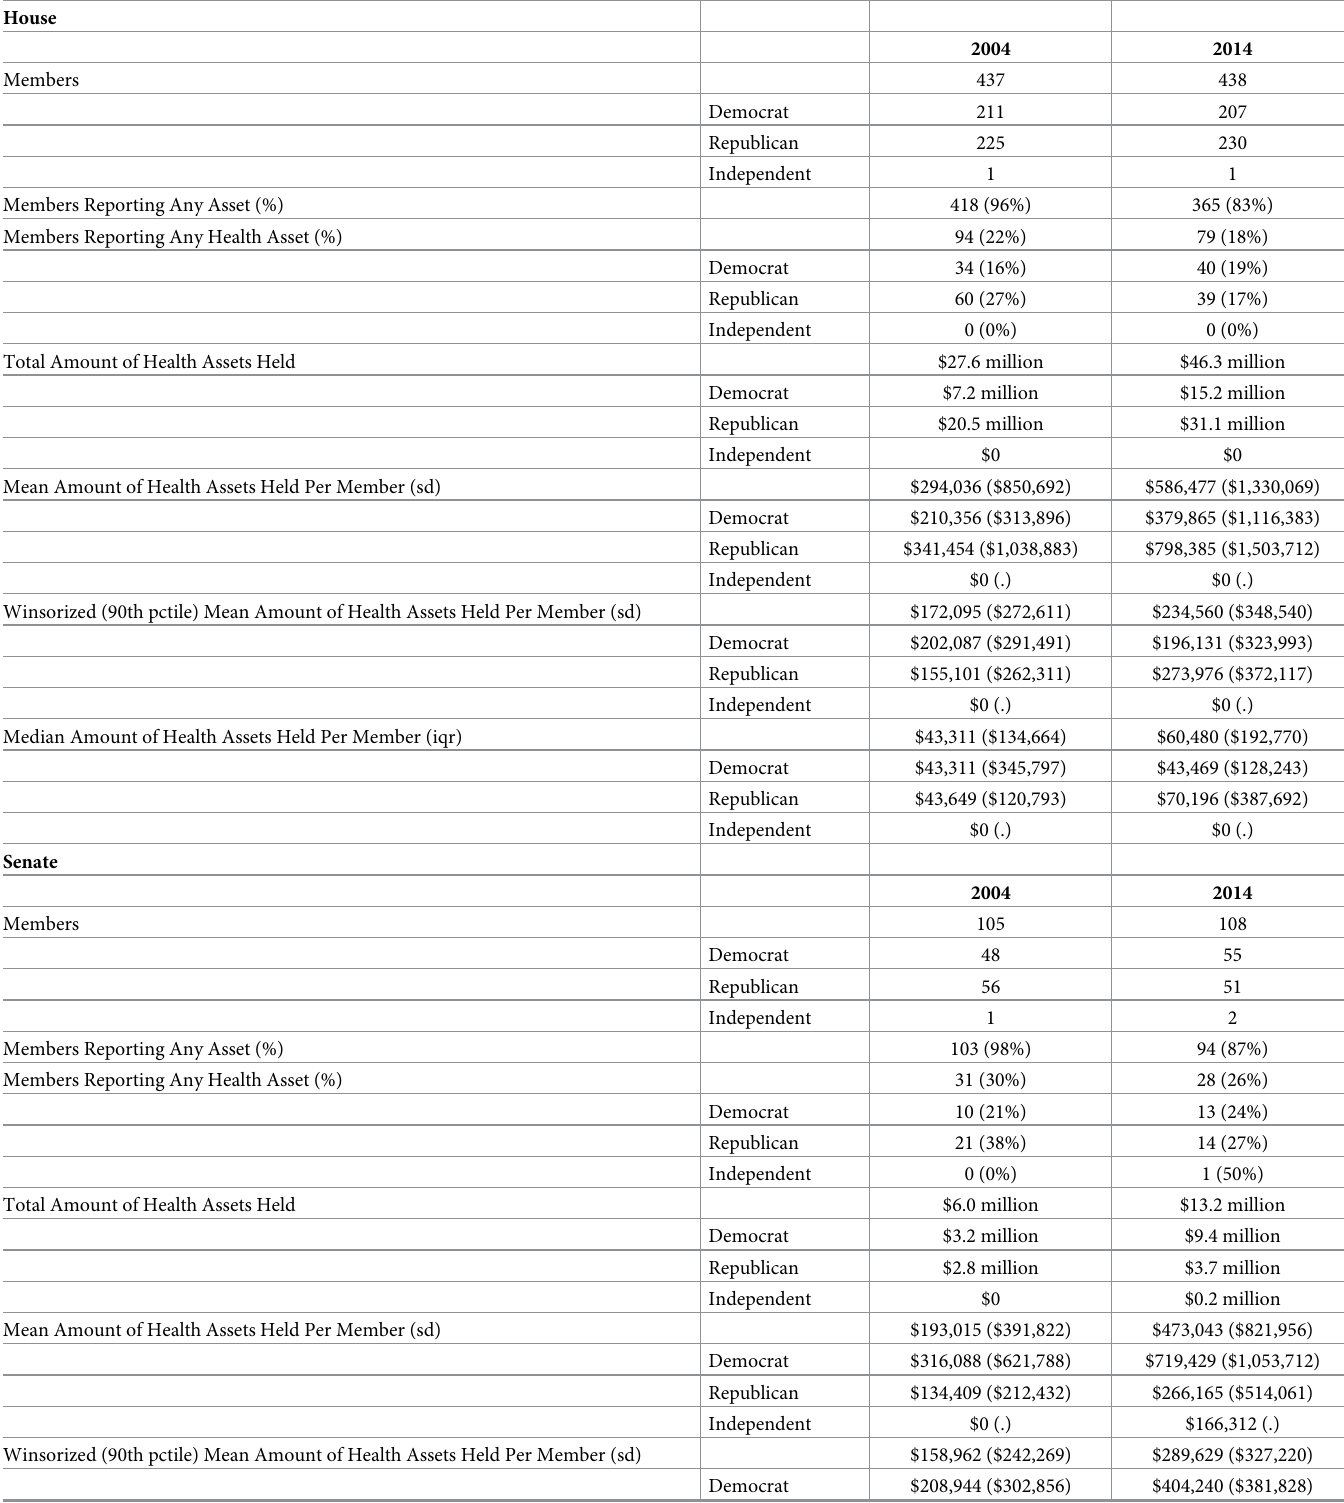
Table 1. Lawmakers’ health care-related assets in 2004 and